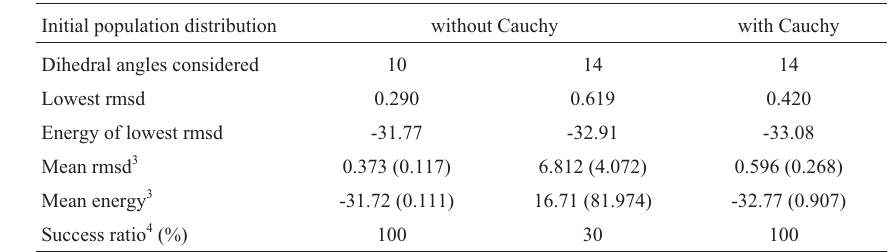
Table 2 - DMP323 flexible docking results.